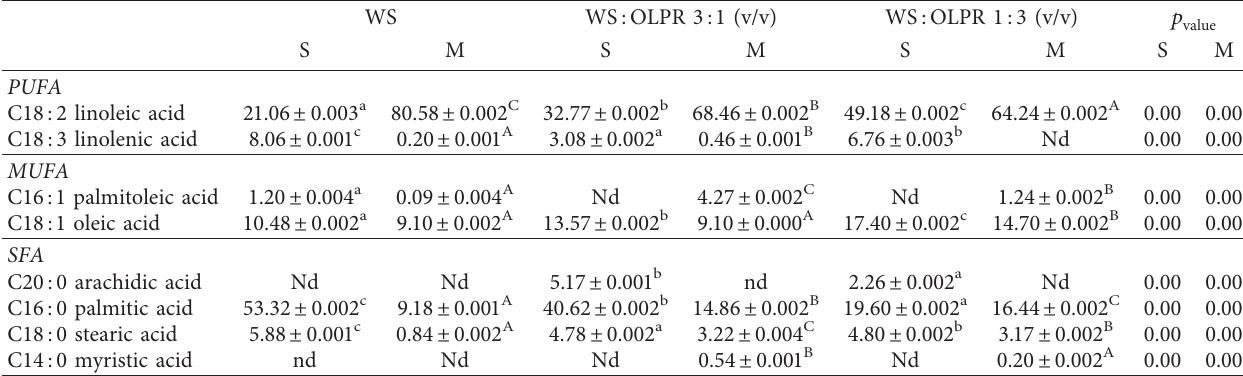
Table 6: Fatty acid profile of substrates and mushrooms (dry basis, % of total fatty acids).